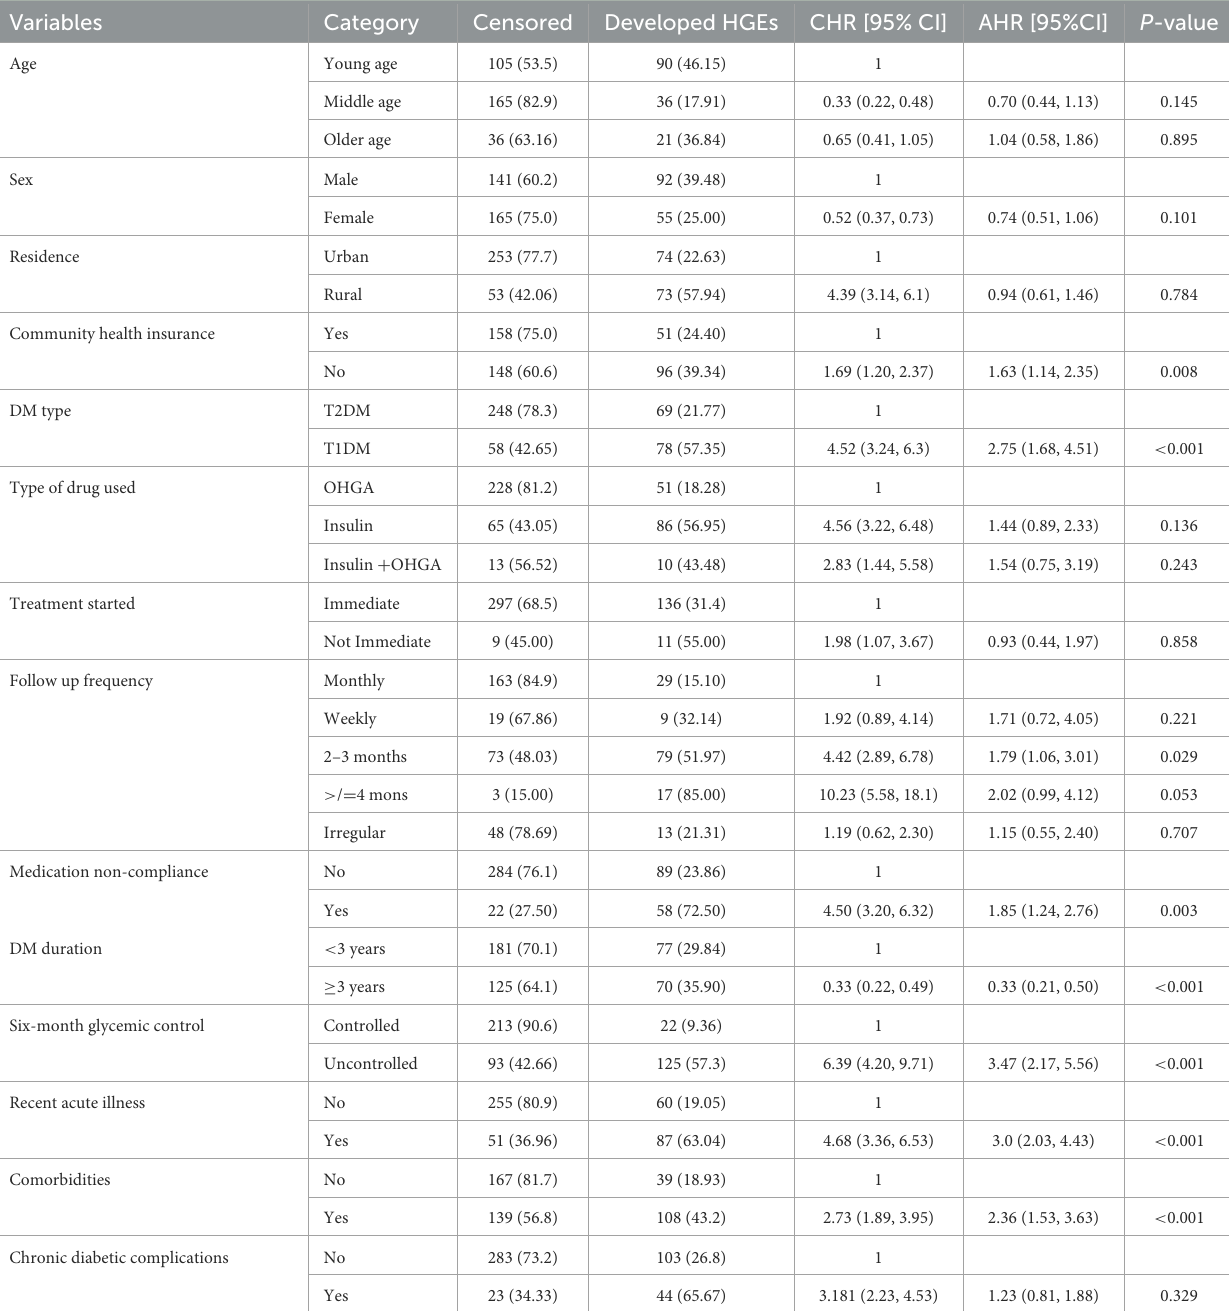
TABLE 4 Bivariate and multivariate Cox regression analysis of adult patients with diabetes in Bahir Dar public hospitals, North West Ethiopia, 2021 ( n = 453).